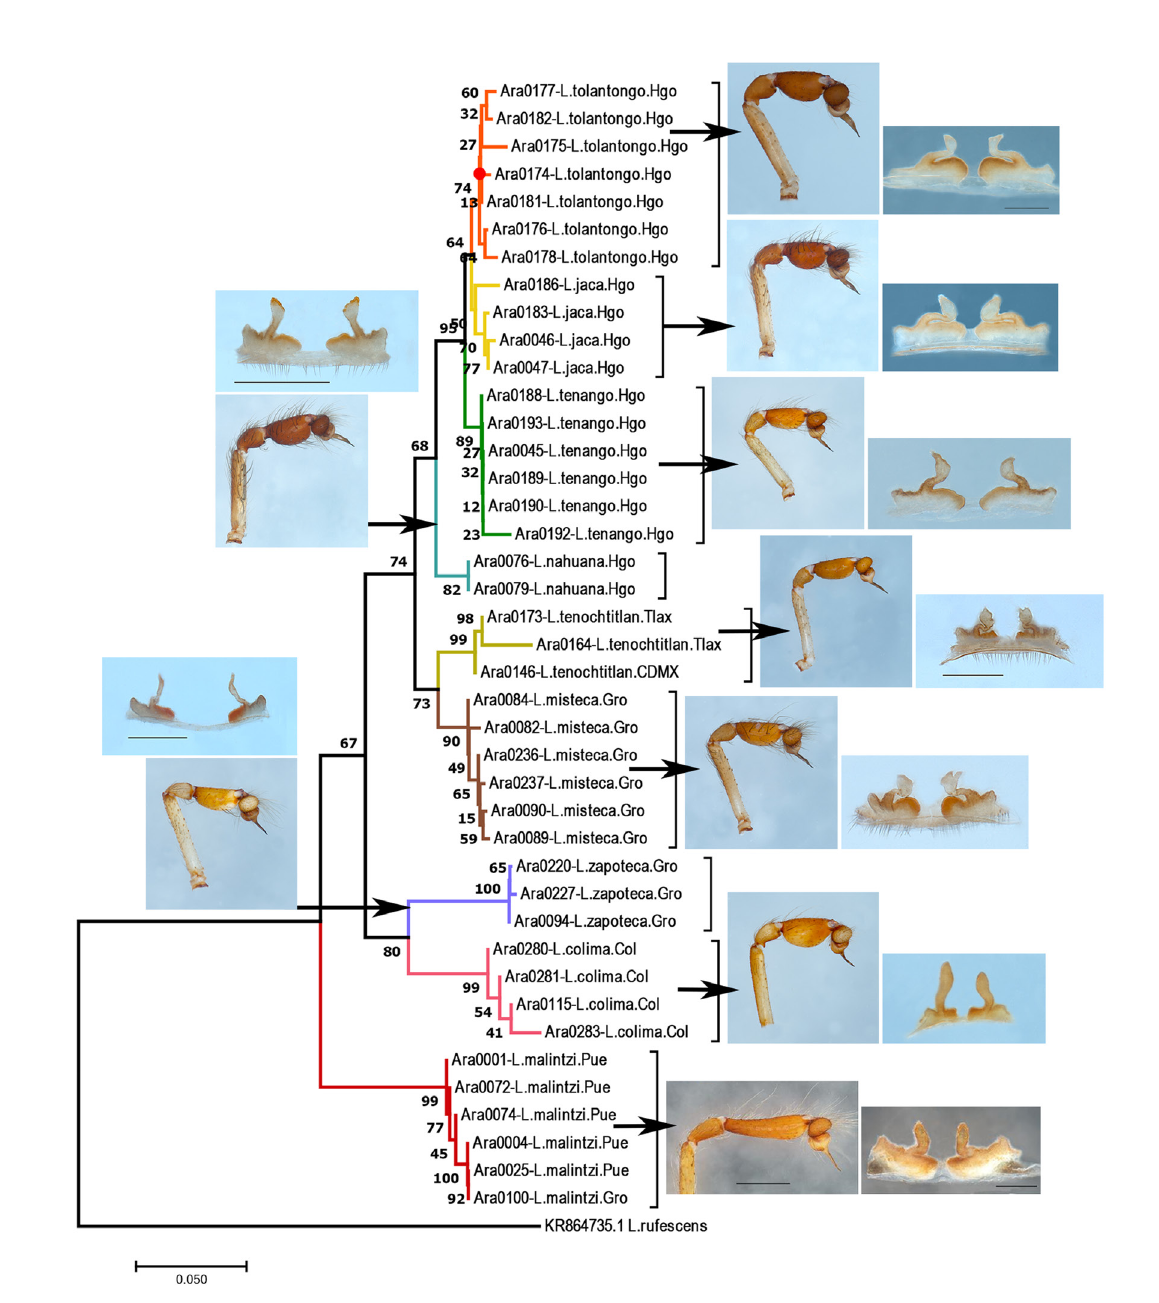
Fig. 53. Neighbor joining tree of ITS2 data of nine species of Loxosceles Heineken & Lowe, 1832 from Mexico. Colors of branches indicate different species. Numbers at nodes represent bootstrap support values. Red circle at node represent Loxosceles tolantongo sp.